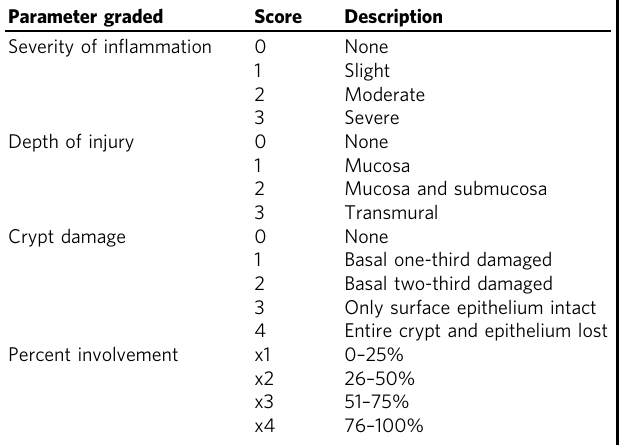
Table 2 Histological grading scheme for DSS